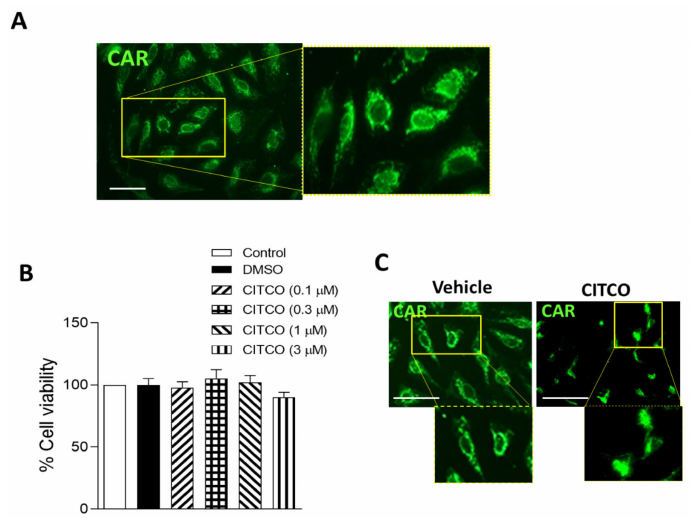
Figure 1. CITCO induces CAR translocation into the nucleus in human vein endothelial cells (HUVEC). ( A ) Cytoplasmic location of CAR detected by immunofluorescence analysis in endothelial cells. Scale bar = 50 µ m. ( B ) Effect of CITCO (0.1–3 µ M) on endothelial cell viability. Data are presented as mean ± SEM of n = 5 independent experiments. ( C ) Representative images showing CAR translocation from the cytoplasm into the nucleus after CITCO (3 µ M) treatment in HUVEC. Immunoreactivity was visualized using an Alexa Fluor 488 secondary antibody (CAR, green). Scale bar = 50 µ